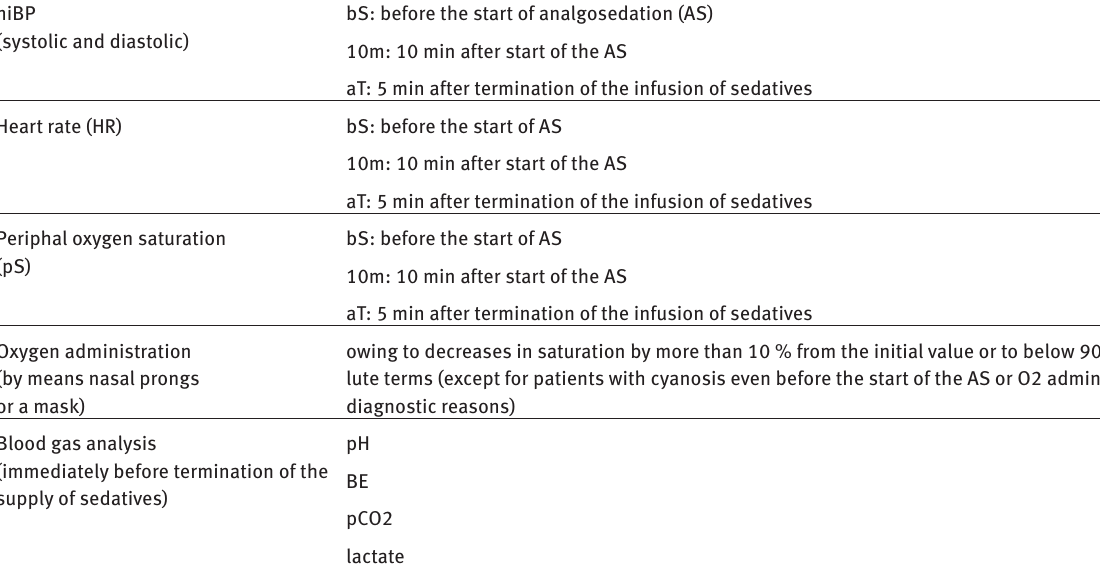
Table 2: Parameters for the comparison of the two